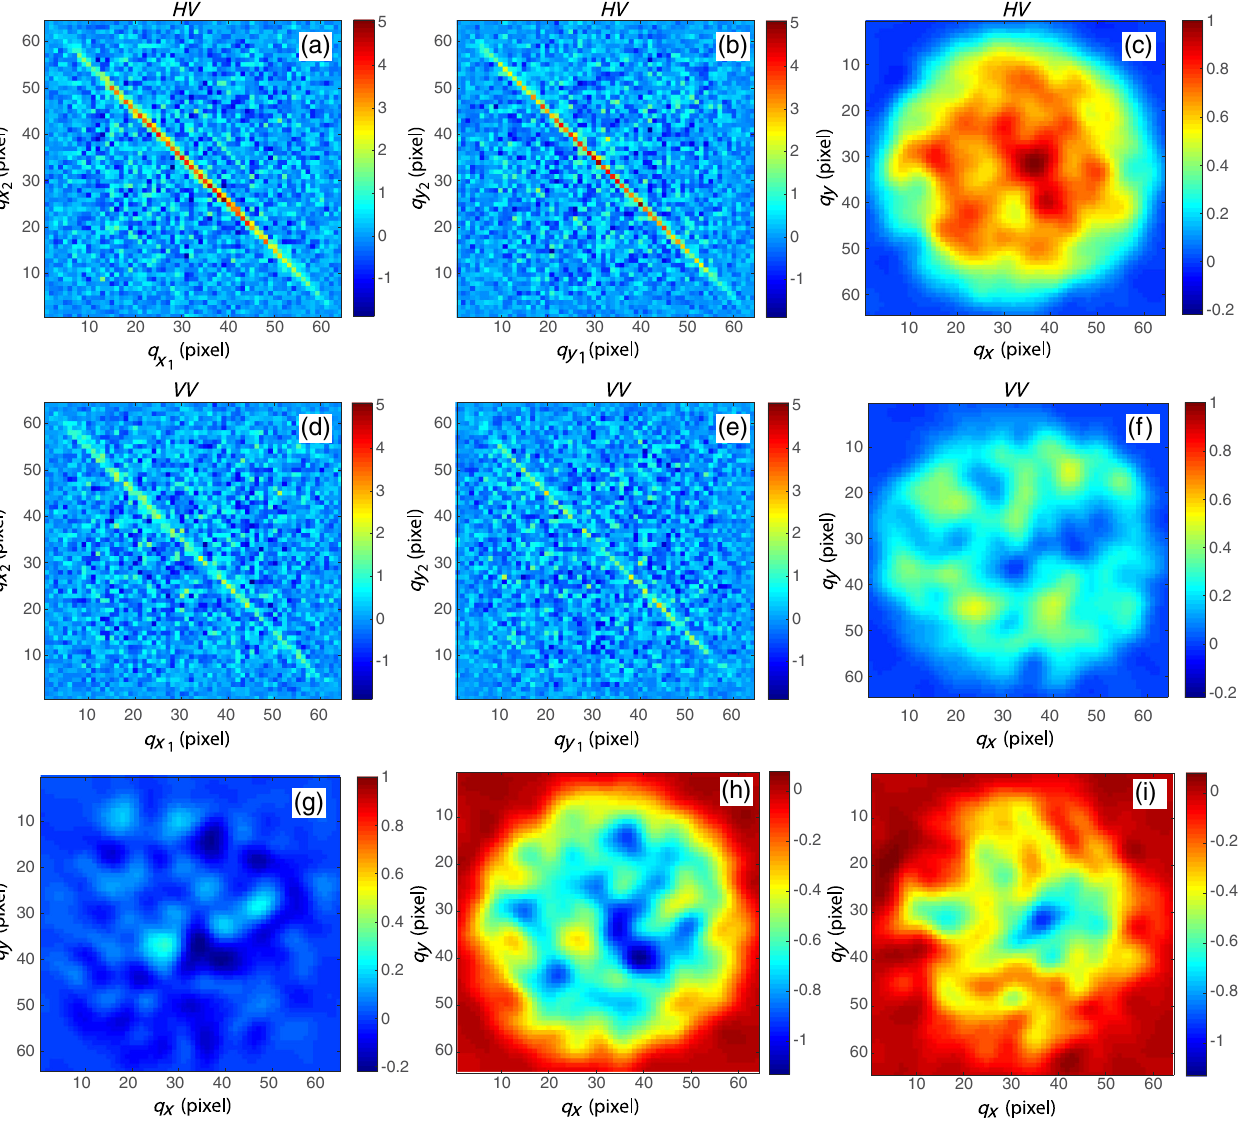
FIG. 8. (a) – (f) Average covariance maps of the intensity fluctuations between pixels of 500 twin SPDC images versus 1D and 2D spatial transverse coordinates q x and q y , for crossed ( HV ) or parallel ( VV ) polarizations. (g) Covariance map of the intensity fluctuations between pixels of 500 independent SPDC images versus 2D spatial transverse coordinates, normalized by the maximum covariance for HV polarization. (h) Difference between the covariance maps (g) and (c). (i) Difference between the covariance maps (f) and